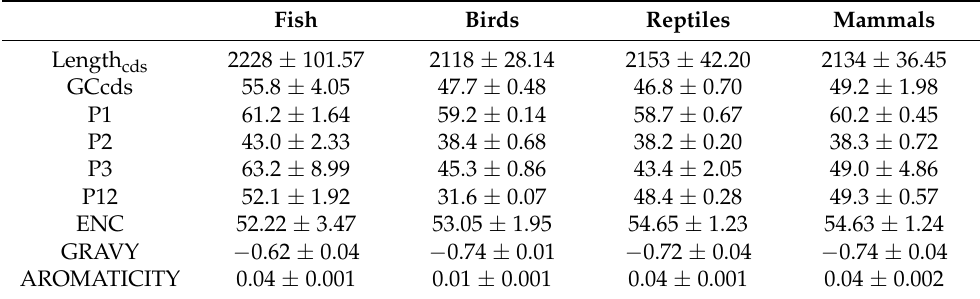
Table 1. Characteristics of FoxP2 gene among different groups of animals. Fish Birds Reptiles